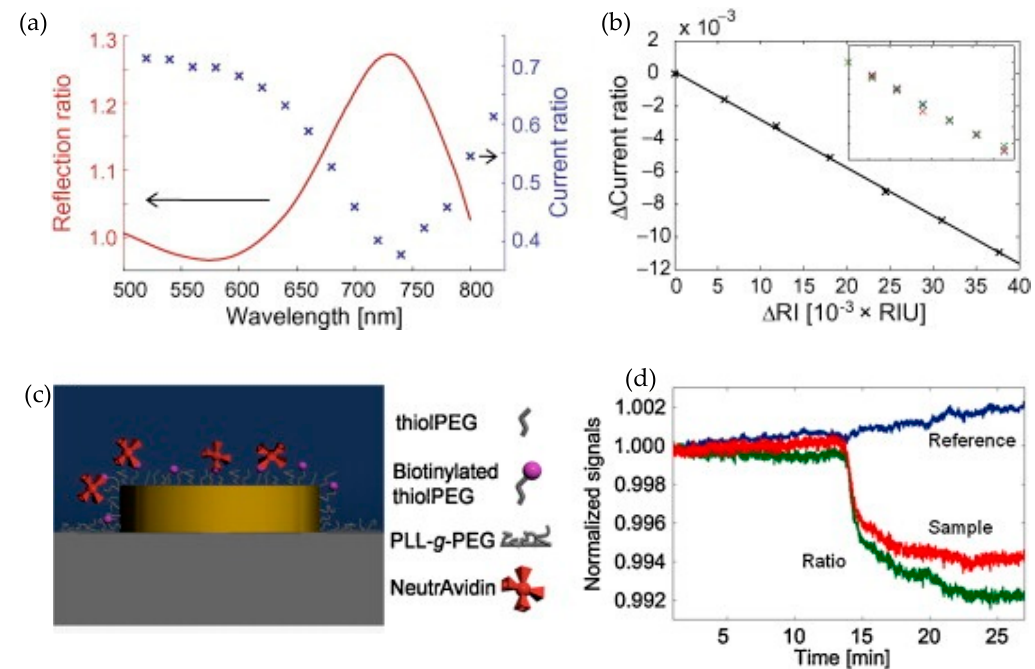
Figure 6. Measurement results of the sensor chip detailed in Mazzotta et al. [68]. ( a ) The red curve is the ratio between the reflection from the nanodiscs and the reference PD showing the reflection response of the gold nanodisc array. The blue curve represents the PD photocurrent ratio for different wavelengths of the incident light. ( b ) The graph represents the change in the PD current ratio versus change in the refractive while keeping the incident light fixed at 780 nm. ( c ) Graphical illustration of specific binding of neutravidin with gold nanodiscs. ( d ) Normalized photocurrent from reference PD (blue), PD with nanodisc array (red) and the photocurrent ratio (green). The curves are normalized with their initial values which were 1.679 V for the reference (blue) curve, 0.693 V for the PD with nanodiscs (red) and 0.413 V for the photocurrent ratio (green). Reprinted with permission from [68]. Copyright © Elsevier (2010).